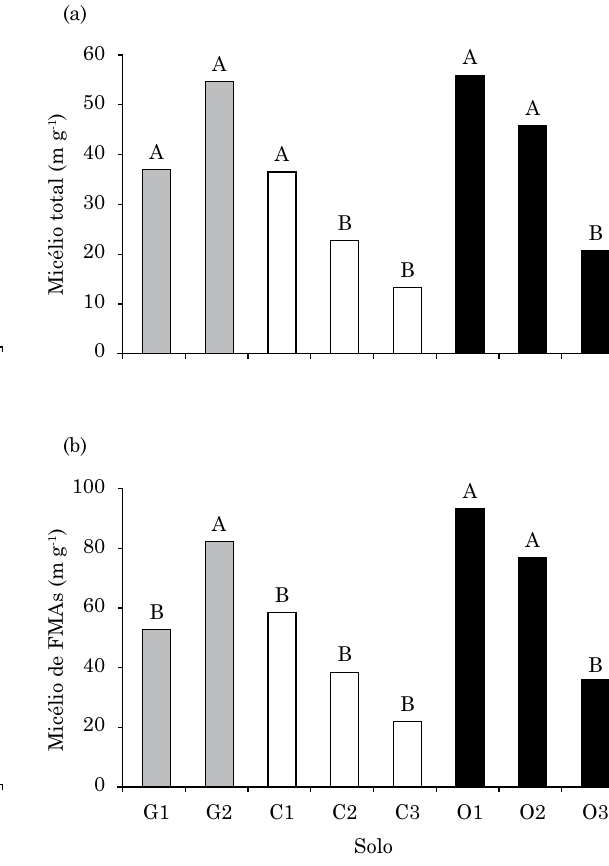
Figura 2. Comprimento de micélio total (a) e comprimento de micélio micorrízico de FMAs (b) em áreas amostradas de Gleissolos (G1-G2), Cambissolos (C1 a C3) e Organossolos (O1 a O3). Barras seguidas pelas mesmas letras não diferem significativamente (p<0,05) pelo teste de